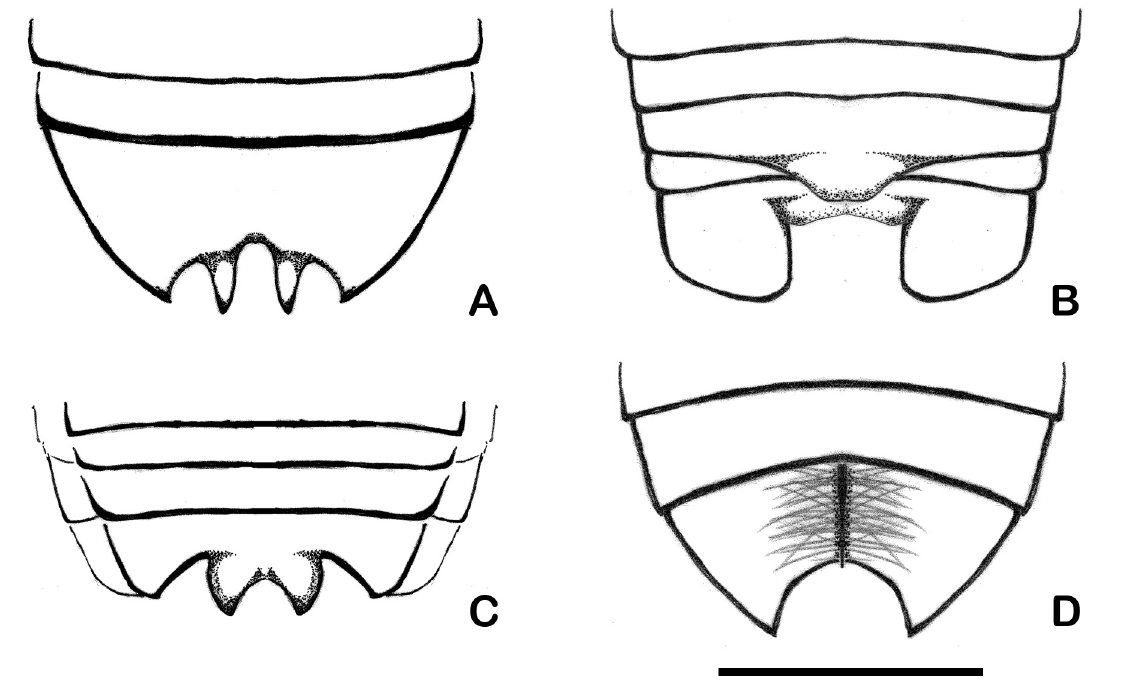
Fig. 4. Last 3 or 4 visible abdominal ventrites of females of species of Xylopertha